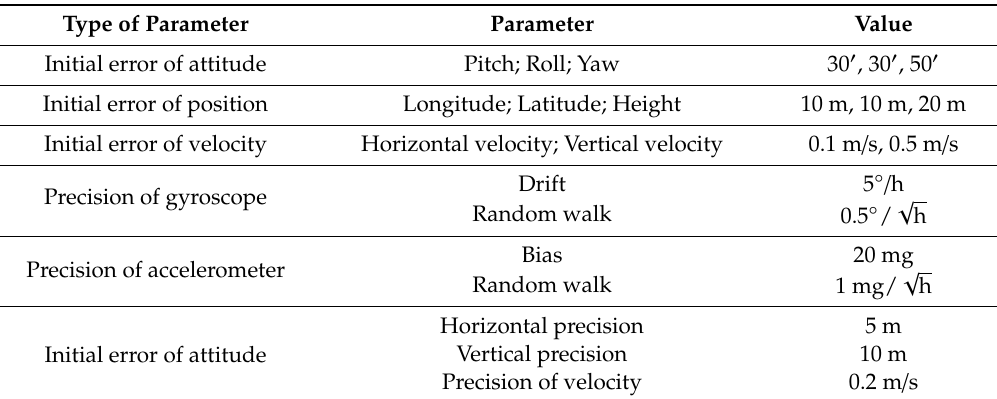
Table 1. Configuration of sensors and initial errors.